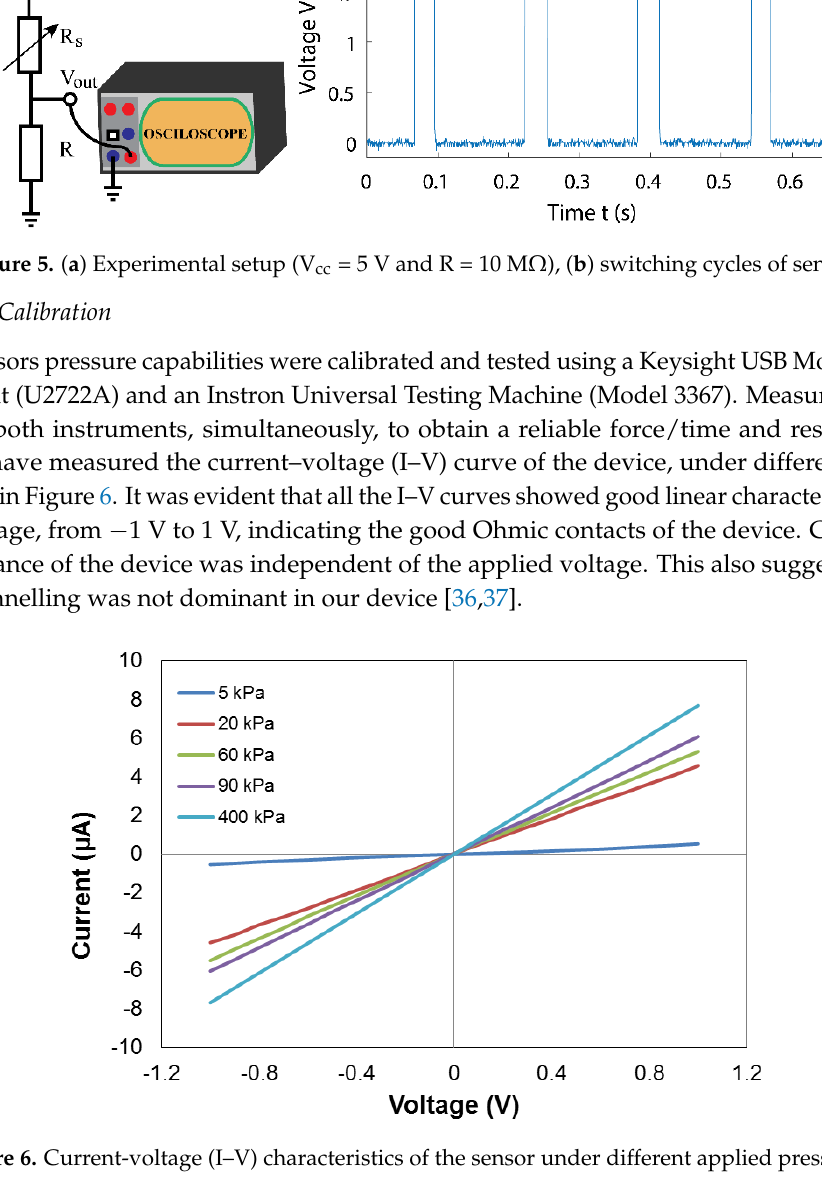
Figure 4. ( a ) Scanning Electron Microscopy (SEM) image of GoP, ( b ) Raman spectrum of GoP.